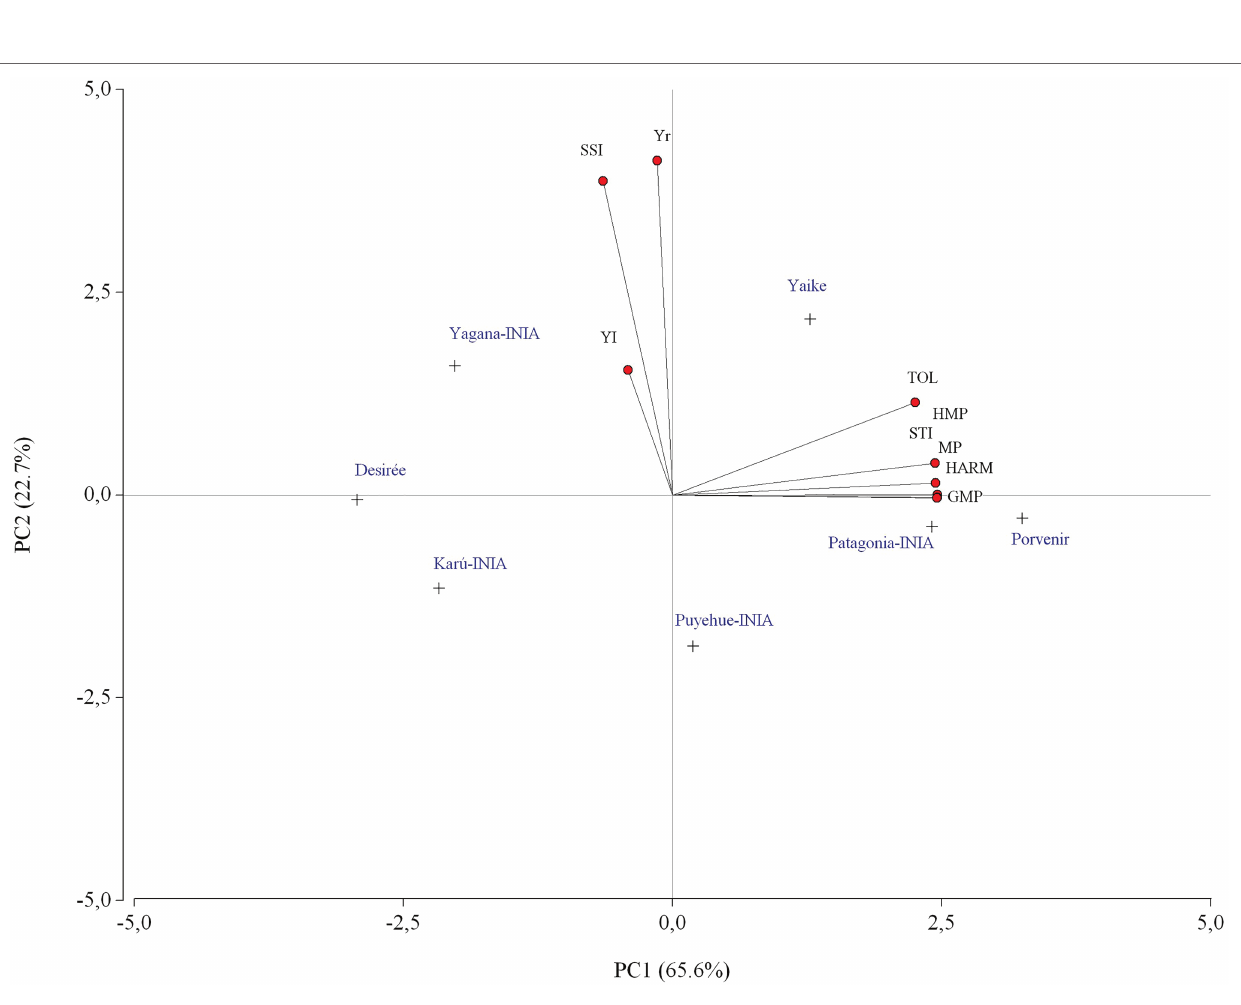
FIGURE 8 | Biplot of the potato varieties under study over different stress tolerance indices under irrigation and rainfed conditions between the 2012–2013 and 2019–2020